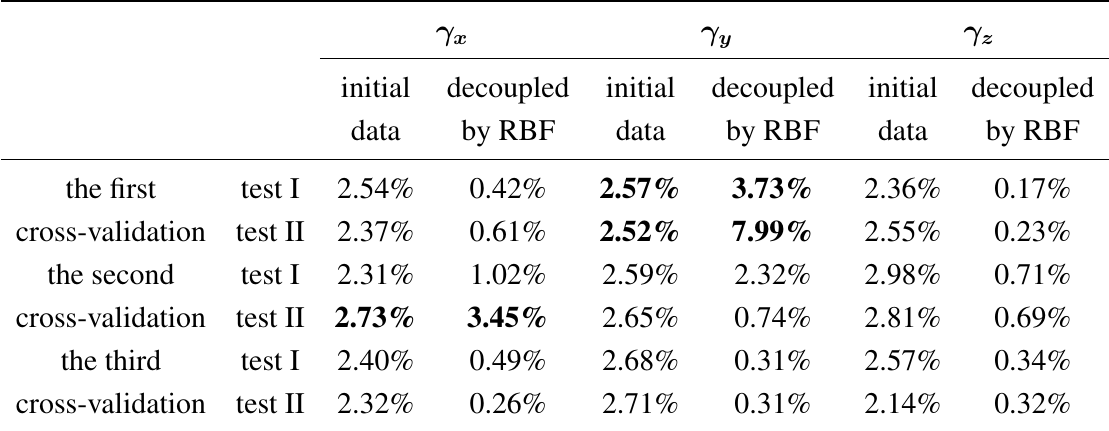
Table 1. Error analysis of initial data and decoupling by a standard MIMO